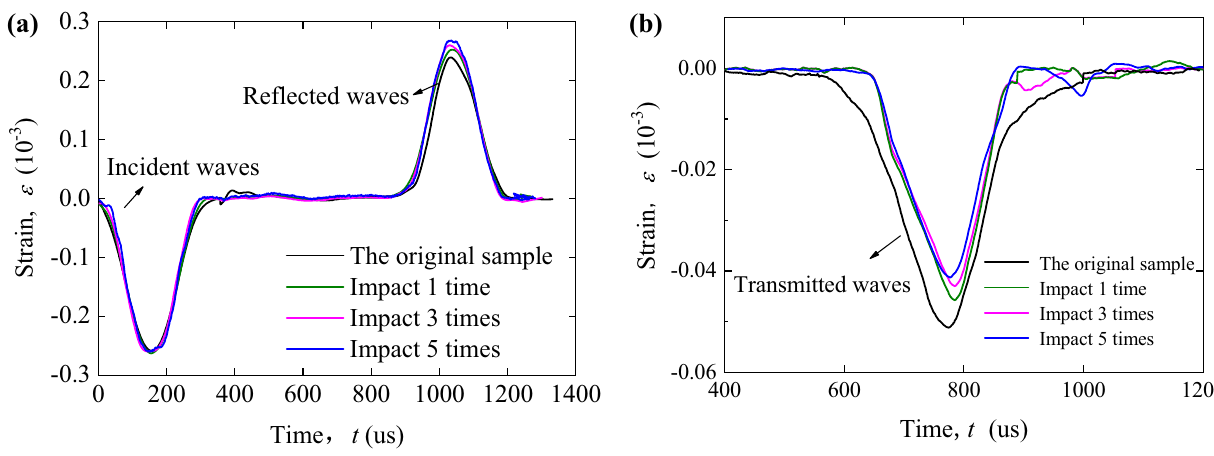
Figure 9. The waveform curves of the jointed rock specimens filled with clay-sand mixture under one- dimensional impact. ( a ) The incident wave and reflected wave; ( b ) The transmitted